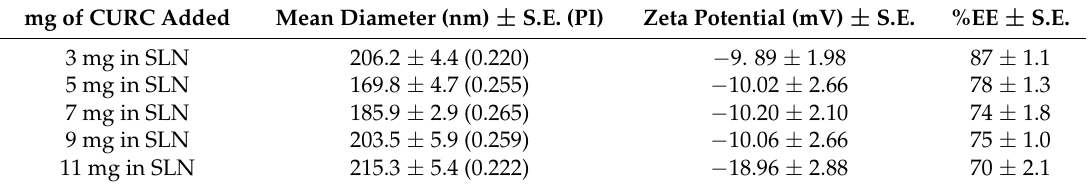
Table 5. Mean diameter (nm) ± standard error (PI), Zeta potential (mV), and entrapment efficiency (%EE) ± standard error of SLNs with increasing amount of CURC, after purification by gel filtration (GF) technique and concentration under N 2 .